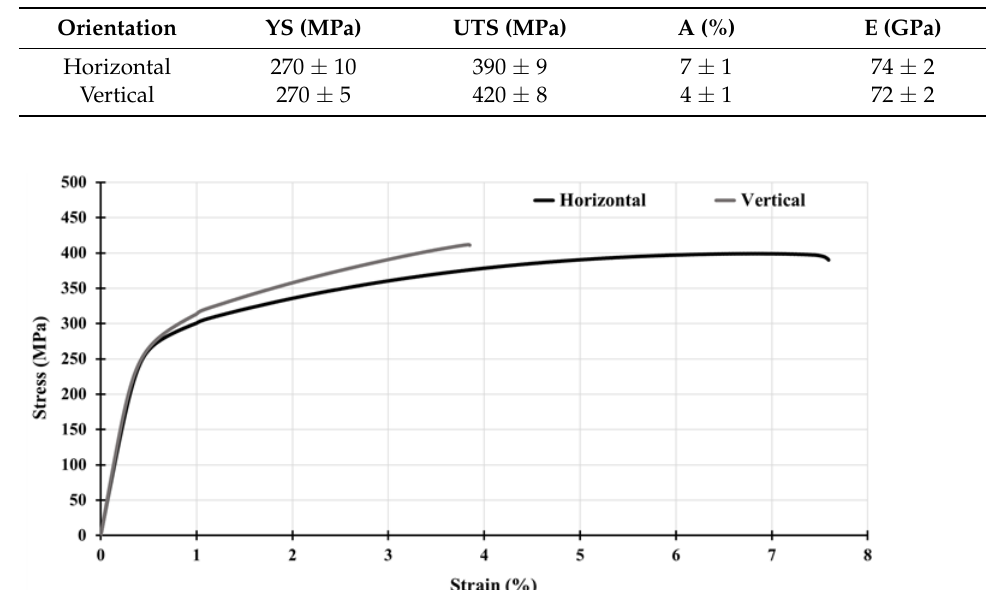
Figure 3. Stress–strain curves of AlSi10Mg alloy tested in different building orientations (samples produced in area 4). Table 4. Tensile properties for each building orientation. Mean values and standard deviations were obtained from all samples tested in each orientation without taking into consideration the produc- tion area.